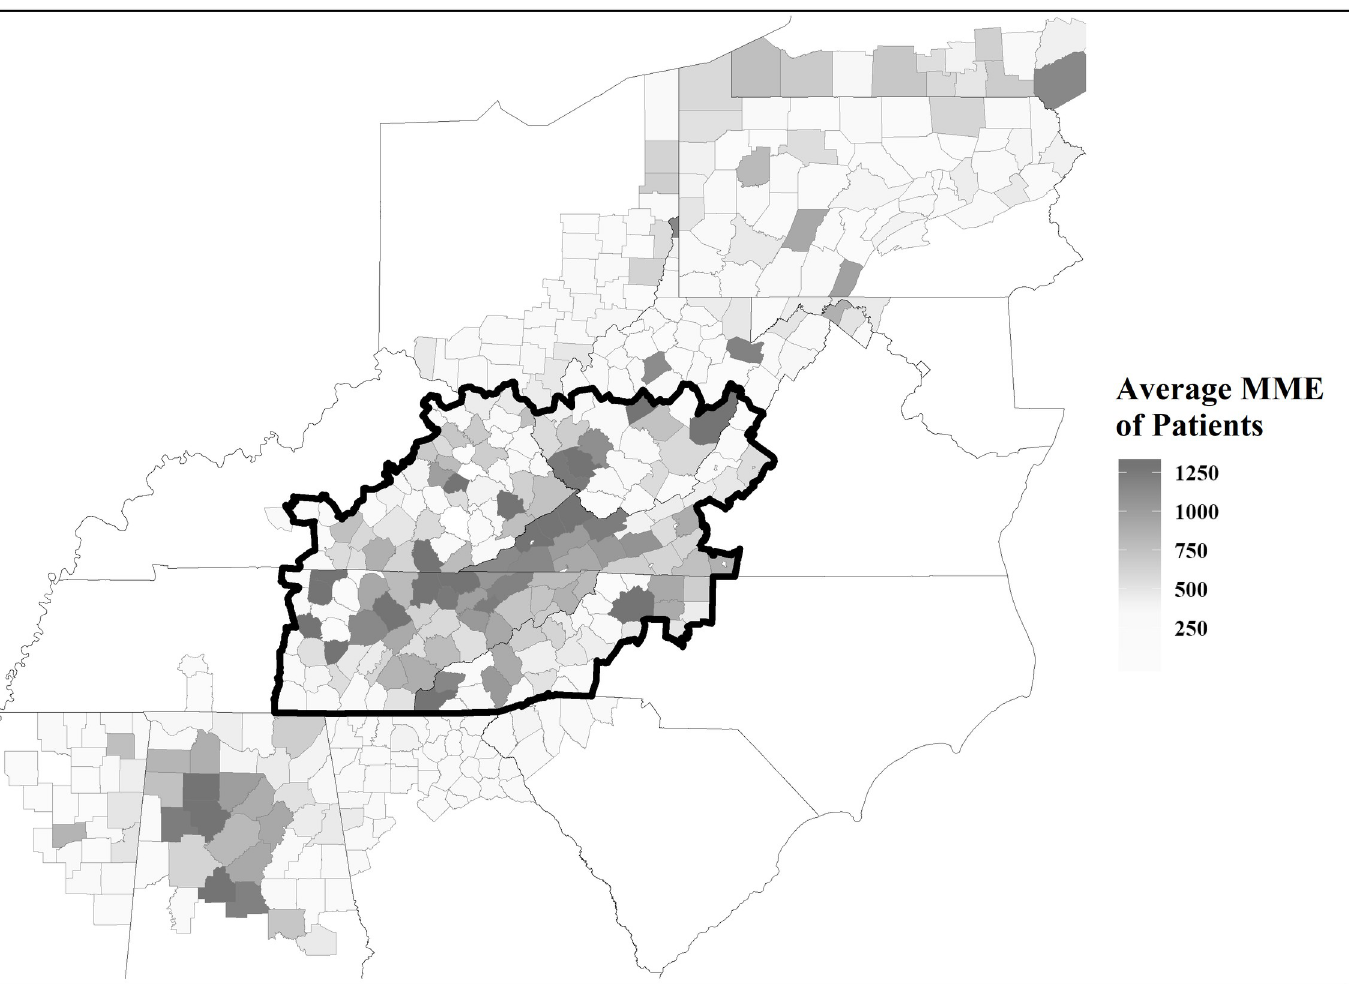
Fig 1. Analytic sample within Appalachia. Thick borders indicate sample boundaries; medium borders indicate state boundaries; thin borders indicate county boundaries. Different shades represent the average MME of patients for all counties in Appalachia. The estimates are based on the first quarter of 2011. The figure was generated using the TIGER/Line Shapefiles product provided by the U.S. Census Bureau